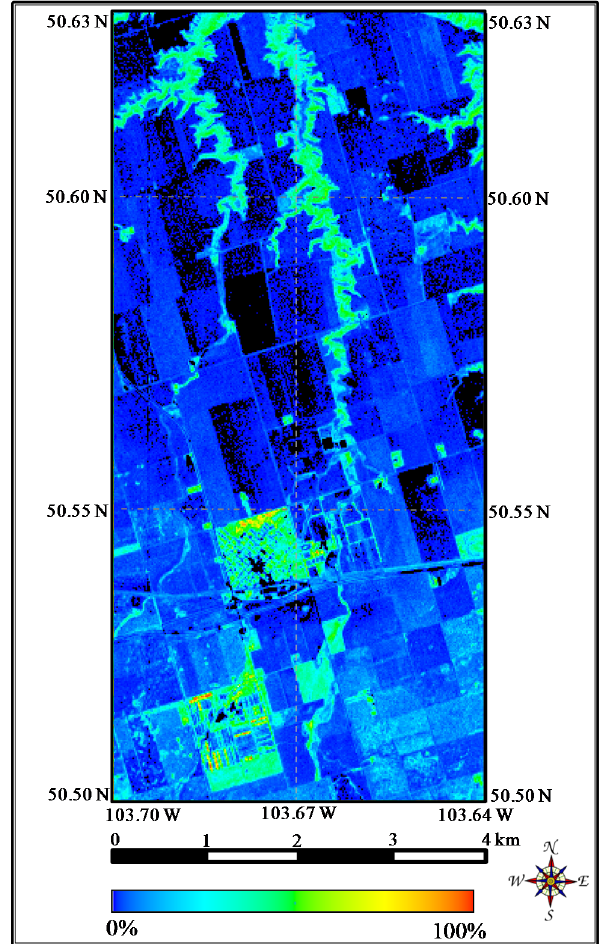
Figure 6. Vegetation cover fraction map derived from the Hyperion cube using